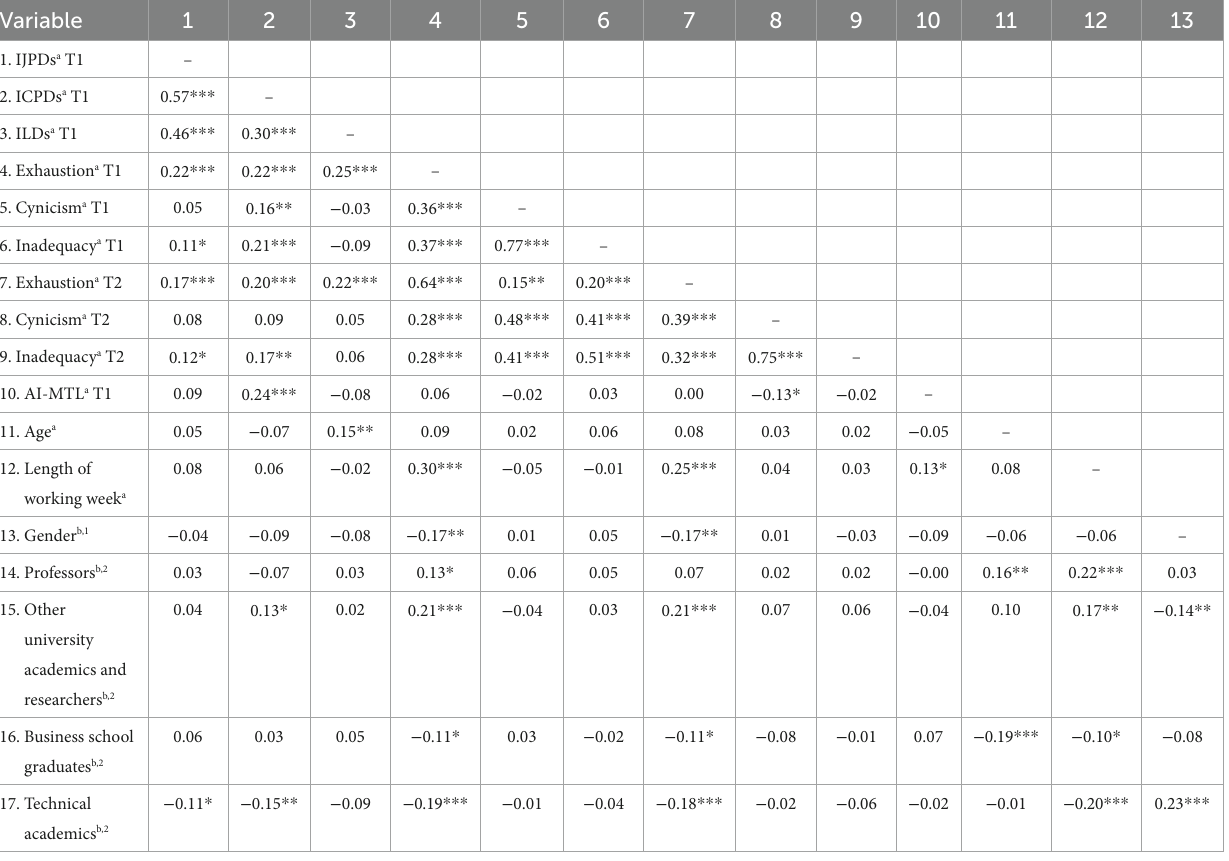
TABLE 1 Correlations for the study variables.